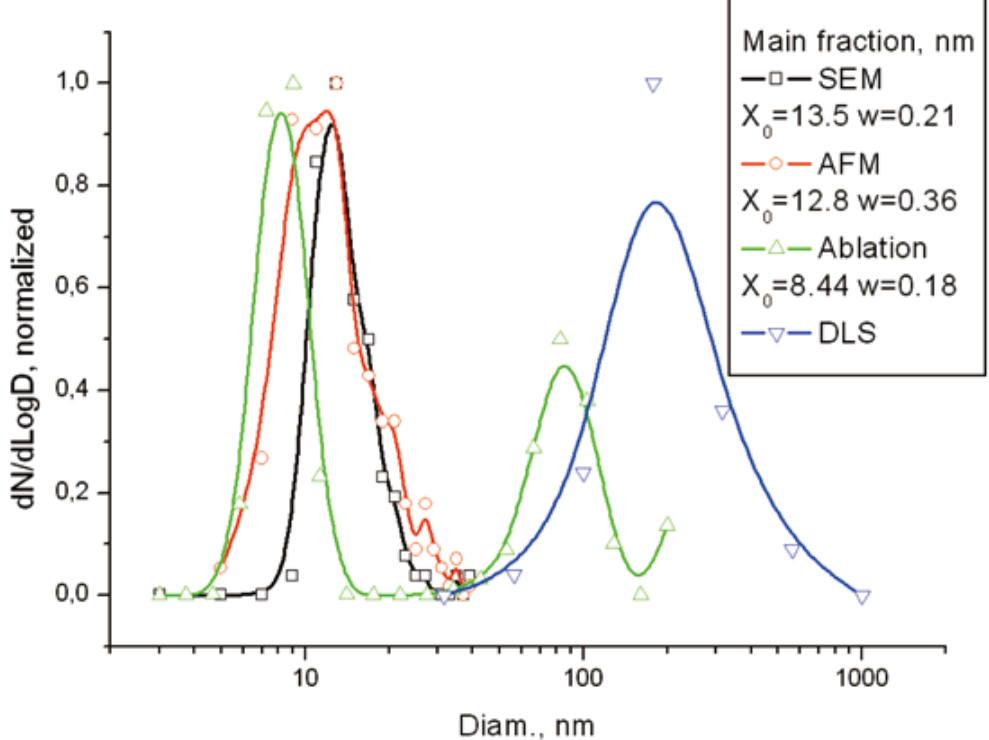
Fig. 3 Size distributions of diamond carbonaceous powder particles registered by scanning electron microscopy (SEM), atomic force microscopy (AFM), dynamic light scattering (DLS) and aerosol products of submillimeter laser ablation